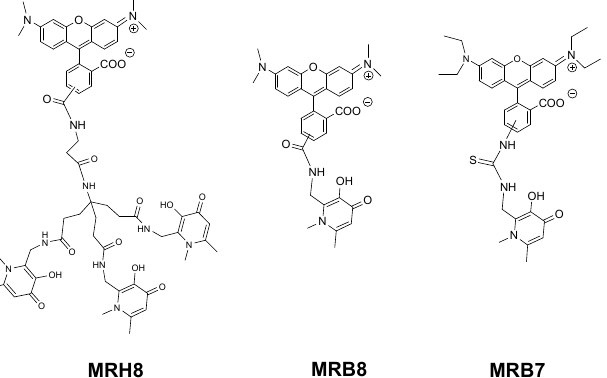
Figure 5. Formulae of fluorescent 3,4-HPO chelators, MRH8, MRB8 and MRB7. The abbreviation and numbering of compounds was assigned according to chelator denticity (MRB i for bidentate and MRH i for hexadentate) and fluorophore ( i = 7, 8).